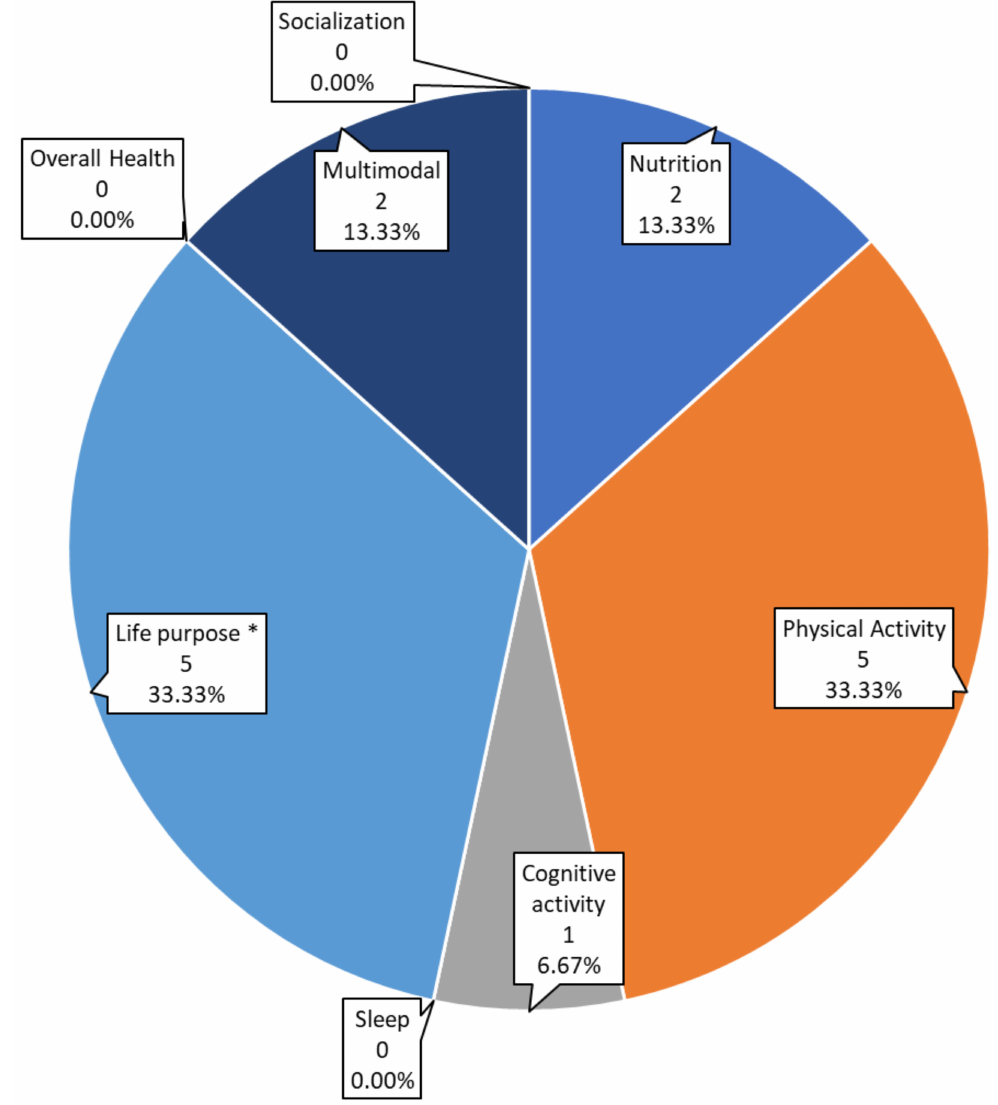
Figure 2. Number and percentage of studies focused on each pillar. *Life purpose includes studies focused on behavior and cognitive behavioral